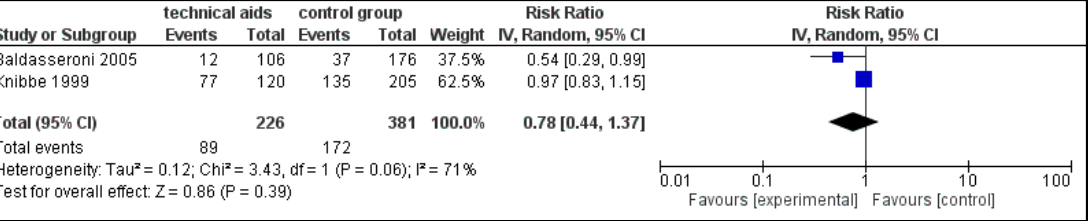
Figure 3. Forest plot of post ‐ intervention 12 ‐ month prevalence rate ratios for back ‐ pain in intervention vs. control (reference) groups.